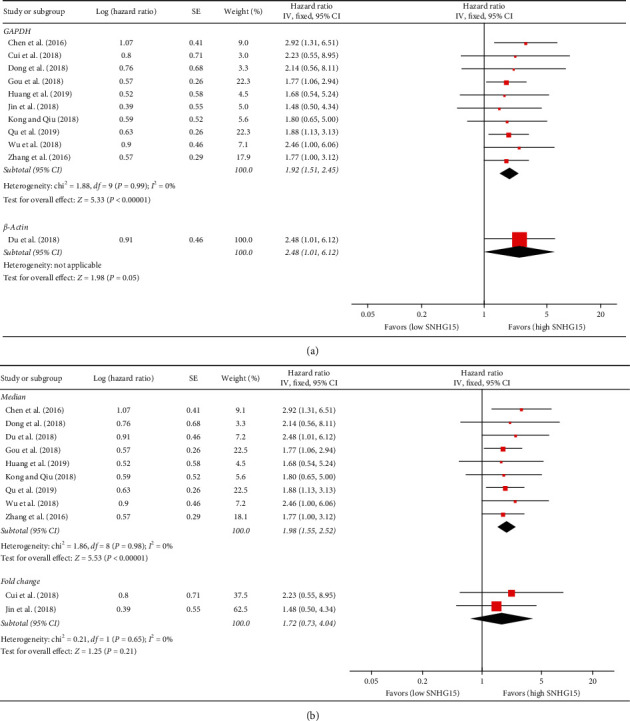
Forest plot for the association between SNHG15 expression and OS in a subgroup analysis based on (a) internal control and (b) cutoff.